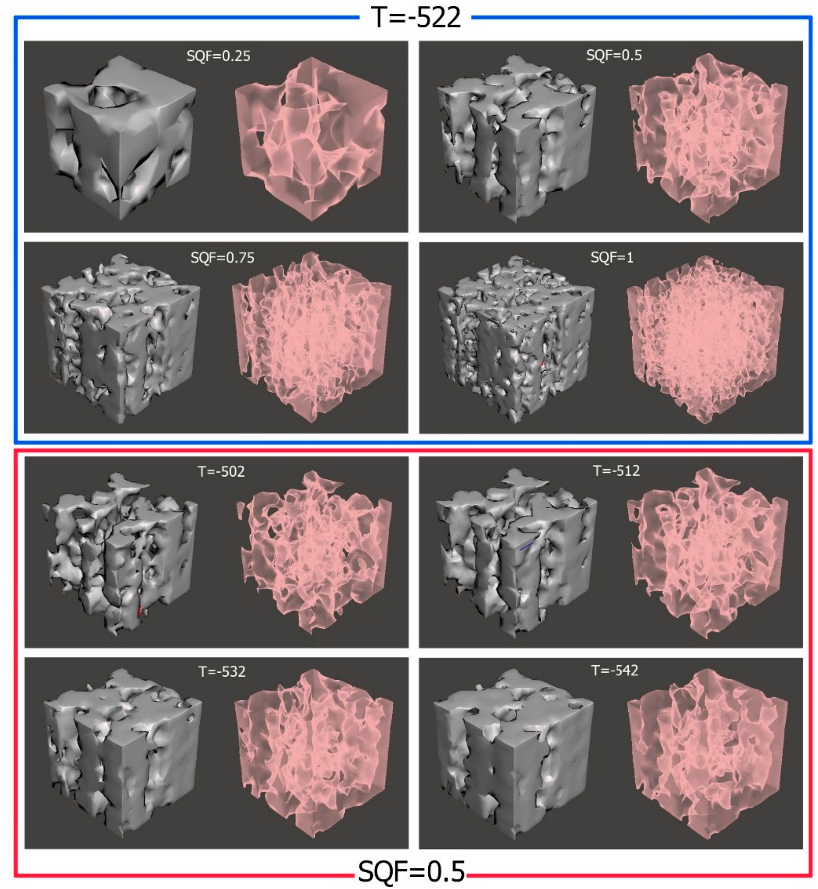
Figure 2. Effects of Surface Quality Factor (SQF) and image Threshold (T) values on the surface and interior structure of reconstructed models.